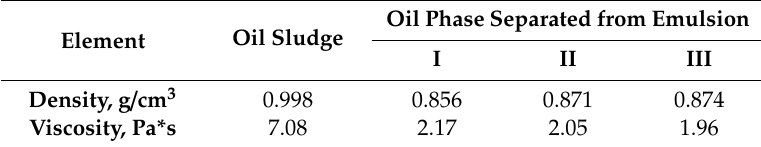
Table 5. Physical and chemical properties of synthetic crude oils.